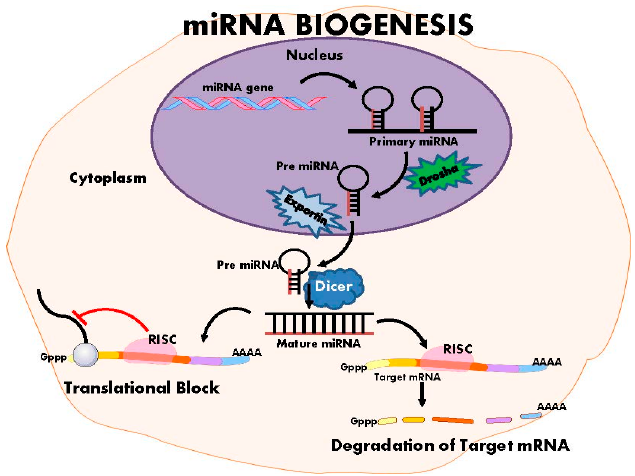
Figure 4. MicroRNA biogenesis. MiRNA biogenesis involves down-regulation of gene transcription via target mRNA degradation or by mRNA translation blockage. RISC: RNA-induced silencing complex.